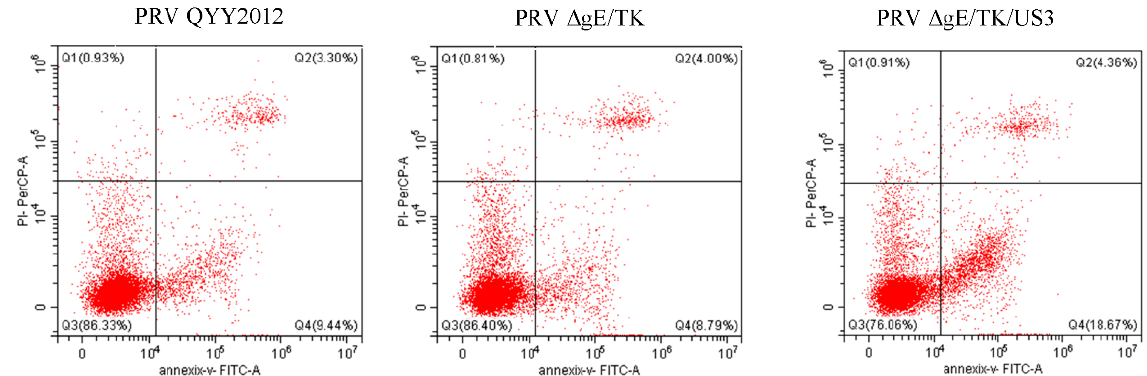
Figure 4. The levels of apoptosis of Vero cells infected with different PRV strains. Vero cells were inoculated with PRV QYY2012, PRV ∆ gE/TK, or PRV ∆ gE/TK/US3 strains. At 24 h after infection, cells were stained with Annexin V ‐ FITC/PI and analyzed by flow cytometry.